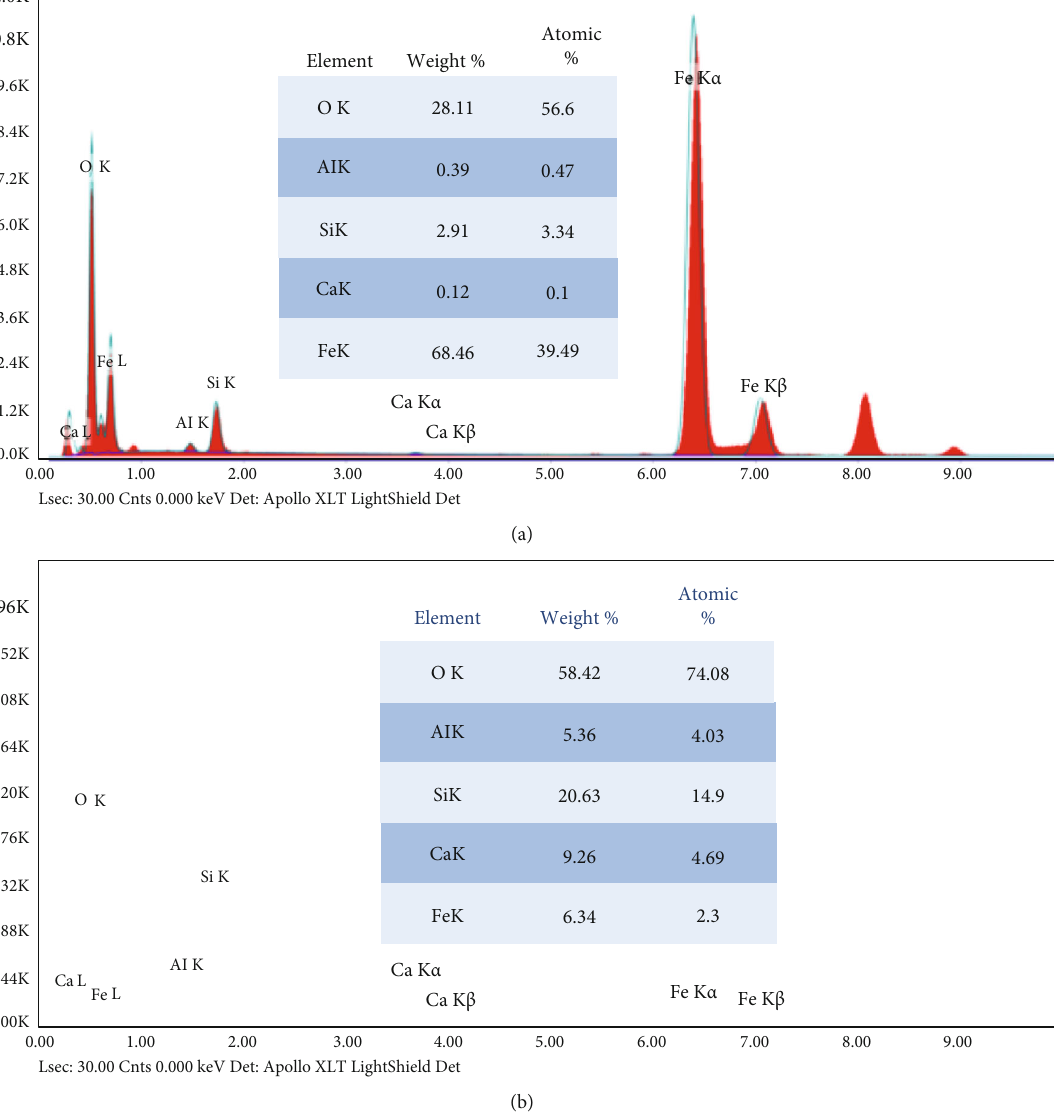
Figure 6: EDS spectra and elemental analysis of FS: (a) high ferrous-rich and (b) less ferrous-rich